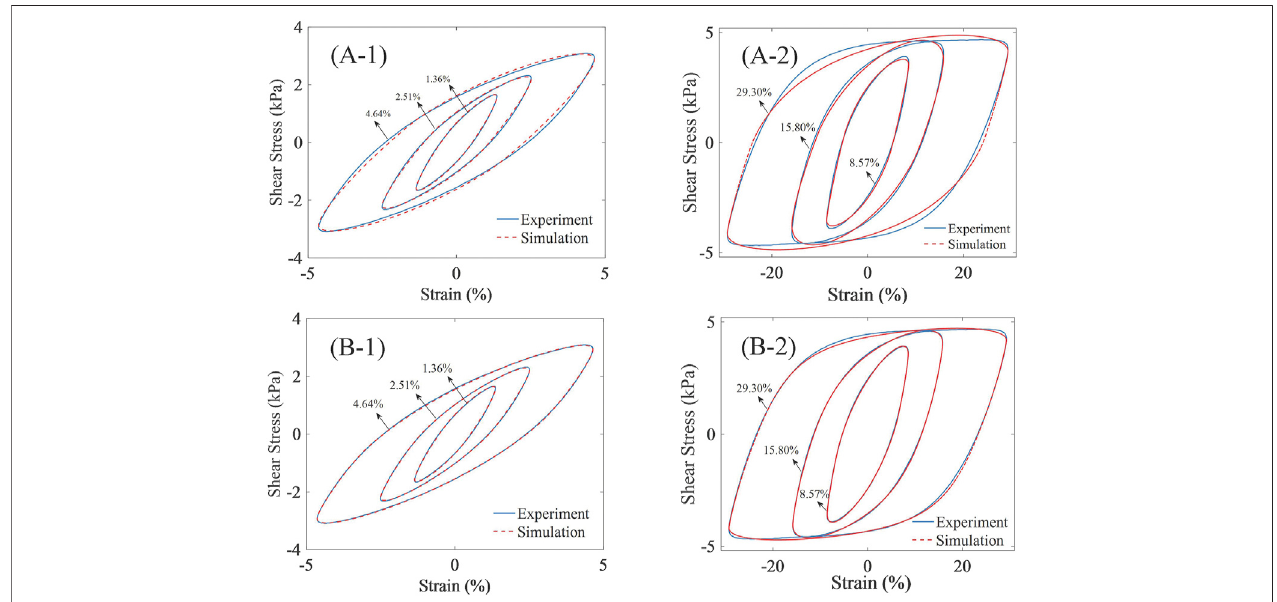
FIGURE 6 | Simulation data and experimental data under different amplitudes: (A) Bouc-Wen model and (B) modi fi ed Bouc-Wen model.